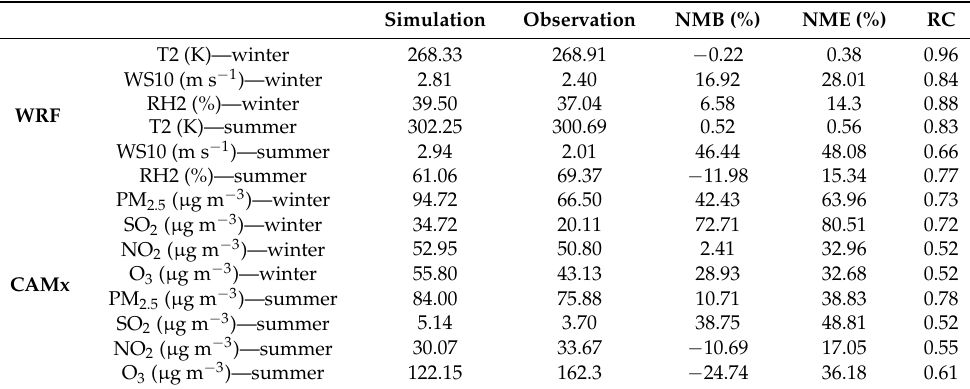
Table 2. The statistical results of the simulated and monitored data in